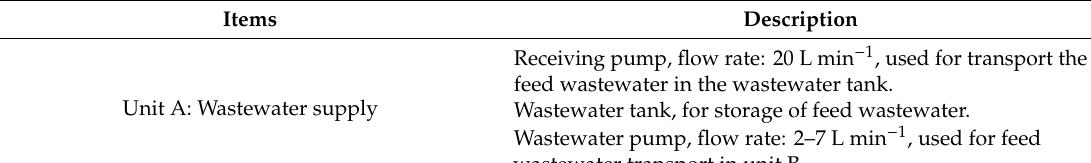
Table 2. General description of the semi industrial plant for two-step neutralization